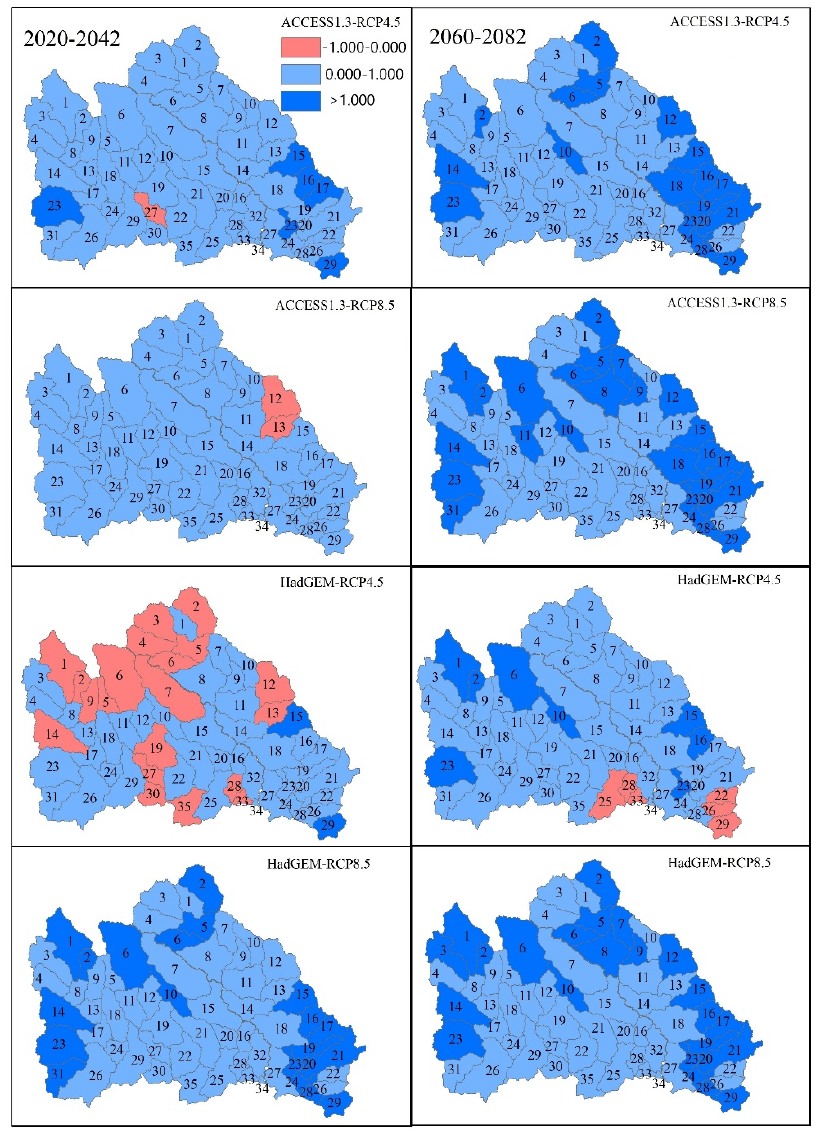
Figure 12. Spatial distribution of total phosphorus under different climate change projections.